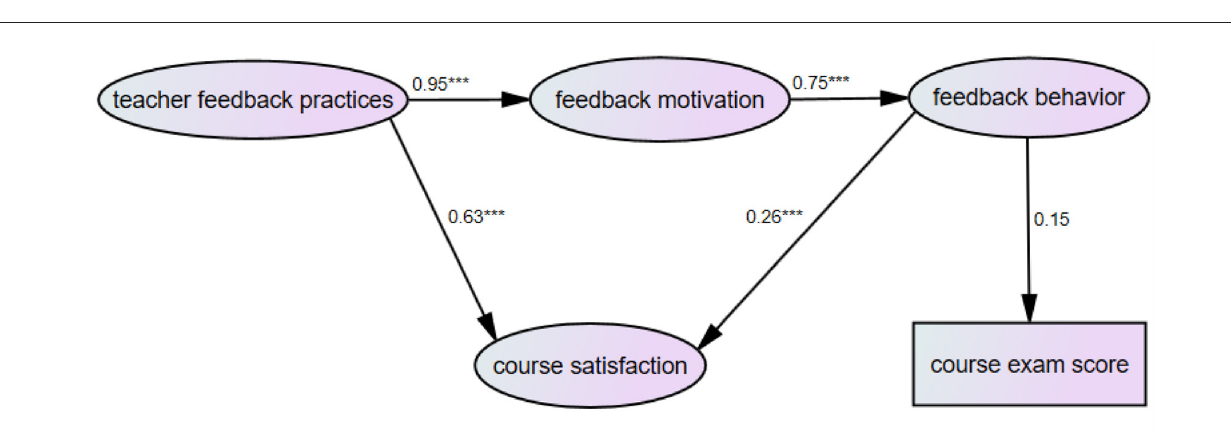
FIGURE 4 | SEM model showing the relations between teacher feedback practices, feedback motivation, feedback behavior, course satisfaction, and course exam scores for students from the key university. Figures represent standardized regression coefficients. *** p < 0.001.